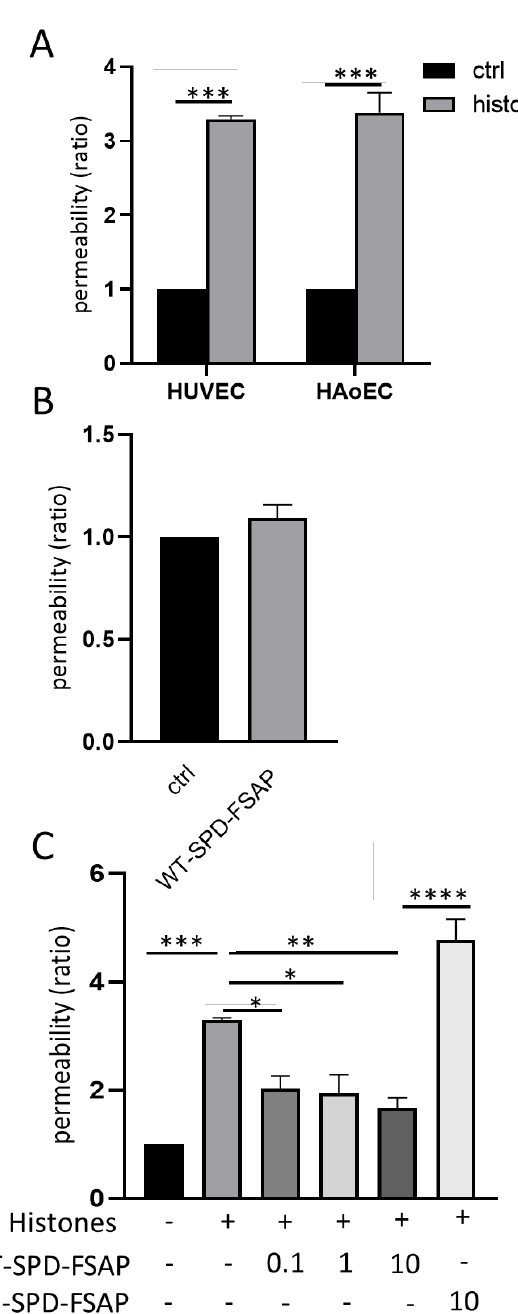
Figure 1. Effect of SPD-FSAP on histones-induced permeability. ( A ) Histones (50 µ g/mL) induced the permeability of both HUVECs and HAoECs. Permeability ratio was calculated as the rate relative to control. Data are presented as mean ± SEM; n = 3, *** p < 0.001. ( B ) WT–SPD–FSAP (10 µ g/mL) had no effect on the permeability of HUVECs. ( C ) 0.1, 1, and 10 µ g/mL WT–SPD–FSAP repressed the increased permeability induced by 50 µ g/mL histones, while 10 µ g/mL MI–SPD–FSAP had no effect. Data are presented as mean ± SEM; n = 3, * p < 0.05, ** p < 0.01, *** p < 0.001, and **** p < 0.0001. N represents 3 independent experiments, with 3 replicates in each experiment.